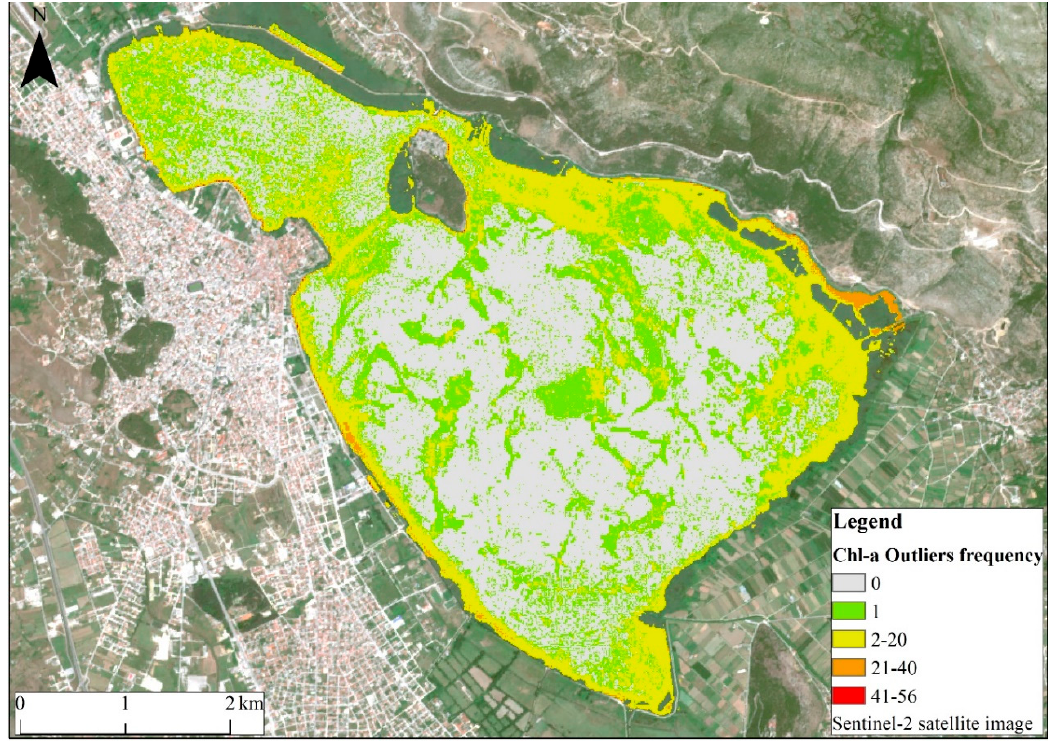
Figure 8. The frequency of chl- a maximum value outlier pixels in lake Pamvotis.